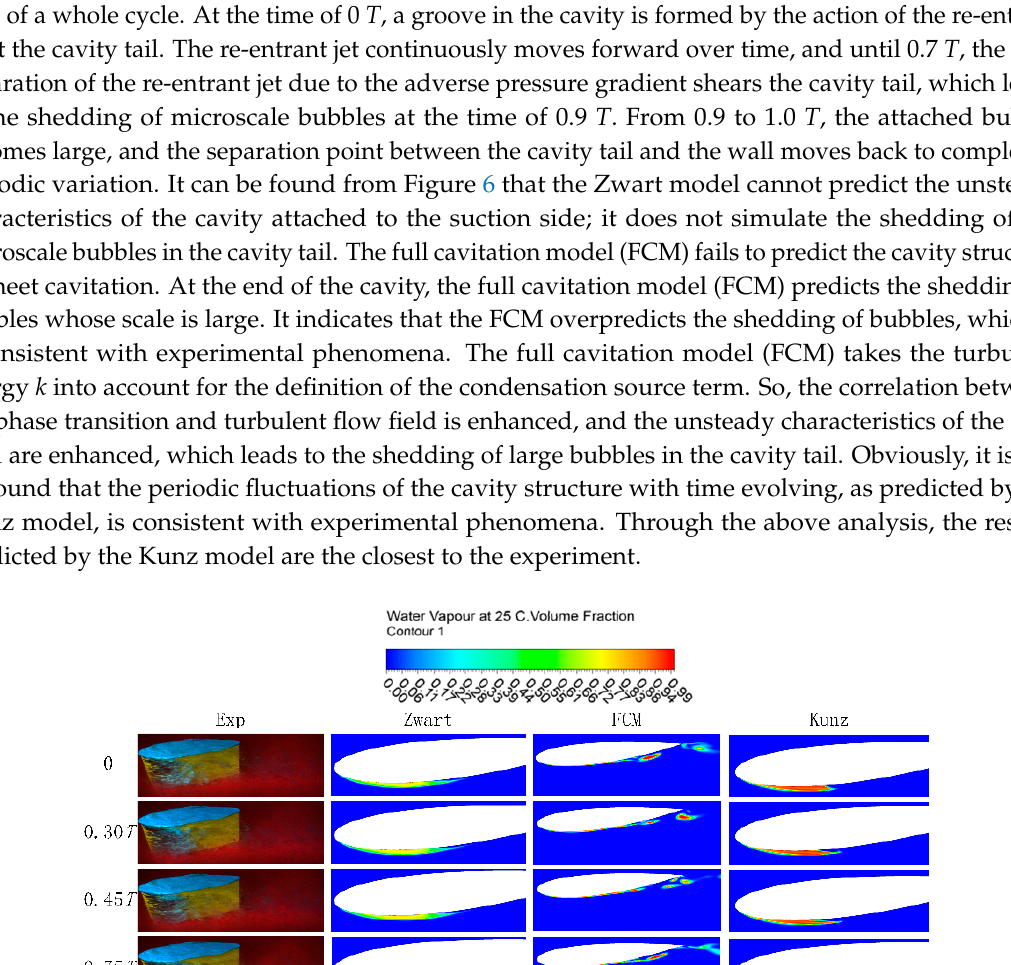
Figure 7. Velocity vector field predicted by three cavitation models ( σ = 1.075, α = 60°). 4.2. Flow Characteristics of Unsteady Cloud Cavitation In the above section, the steady and unsteady characteristics of sheet cavitation are mainly analyzed. In this section, the investigations are focused on the unsteady characteristics of cloud cavitation. The cloud cavitation is a complex physical phenomenon with obvious strong unsteady characteristics. Figure 8 shows the evolution of the cavity structure over time, with the experimental data and numerical results. Three cavitation models clearly captured the periodic process of the initial,